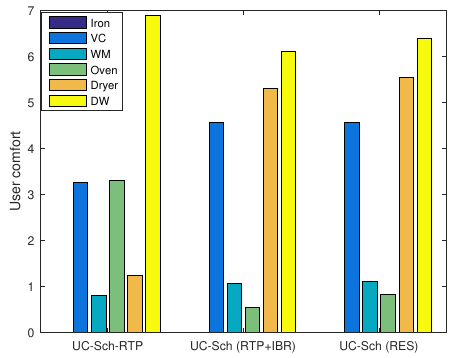
Figure 11. Results of user comfort for scheduled with RTP, RTP+IBR and